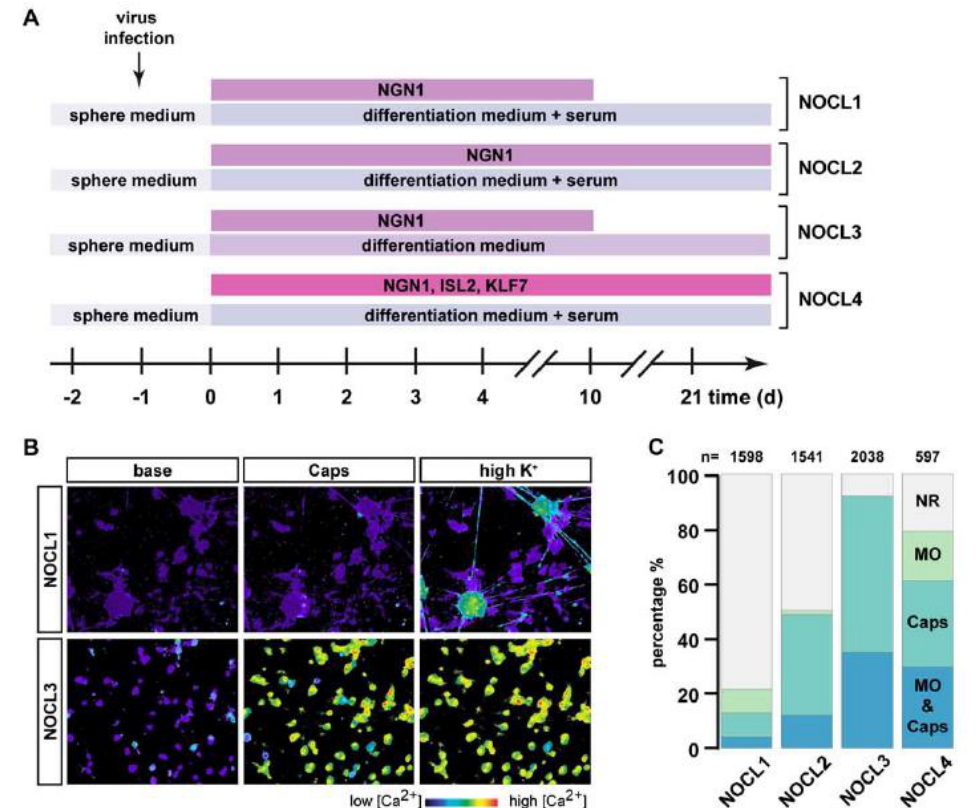
Figure 2. ( A ) Schematic illustration of the differentiation procedures used to generate different types of hESC–derived nociceptor–like cells (NOCL1–4), showing the differences in medium composition ( ± serum), the type of transcription factors used (NGN1, ISL2 and KLF7) and the duration of their expression (10 days or until the end of the culturing period). ( B ) Representative pseudo–colored images of calcium responses observed in NOCL1 and NOCL3 cells loaded with Fura2. Shown are the respective Ca2+ levels before (base) and during stimulation, with either the TRPV1 agonist capsaicin (Caps, 1 µ M) or high K + Ringer solution for general depolarization of neurons. ( C ) Stacked bar charts, show the percentage of NOCL1–4 cells responding to mustard oil (MO, 200 µ M), capsaicin (1 µ M), or both agonists using calcium imaging. ( n = 4). Data shown as average percent ± SEM.